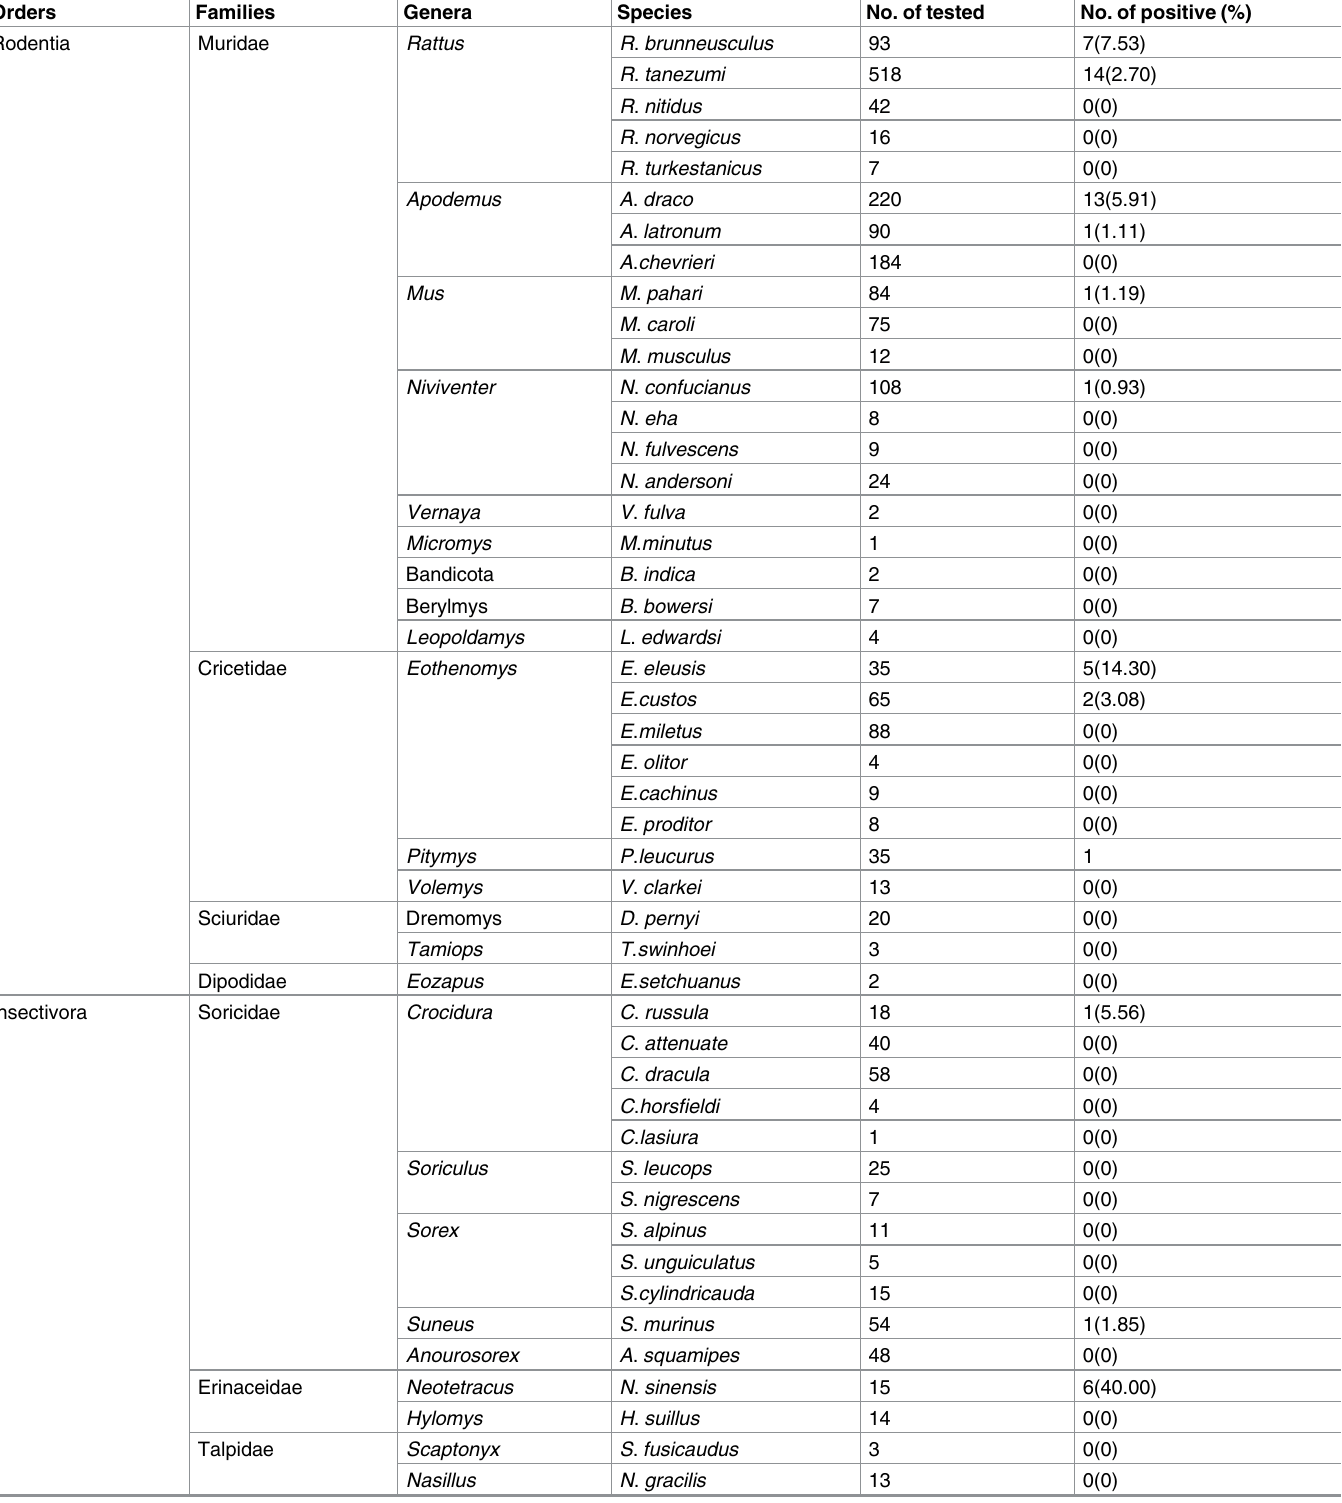
Table 2. Prevalence of B . microti in small mammals of different